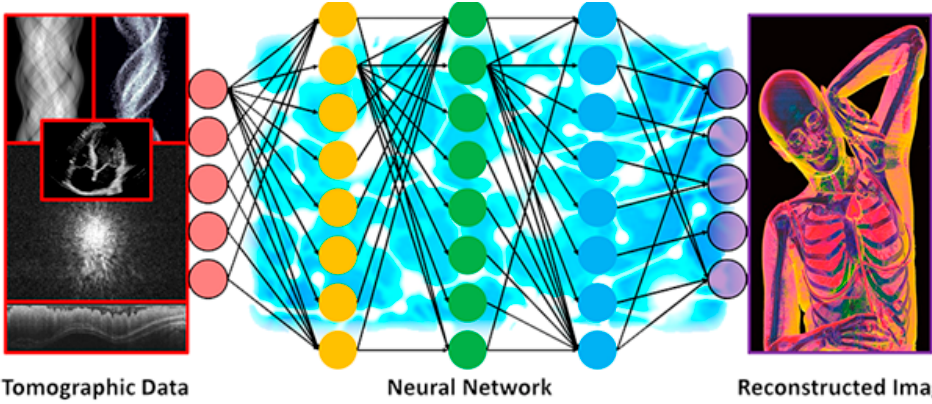
Figure 11. Process of segmenting medical images using deep learning [78].